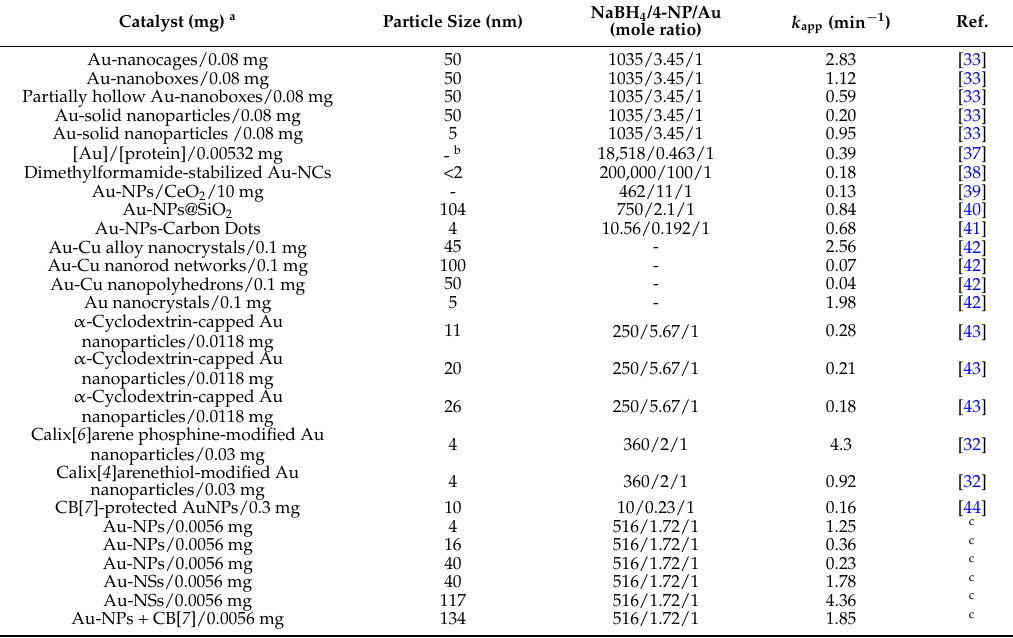
Table 2. Comparison of 4-NP reduction by various gold nanoparticles from the literature and this work at room